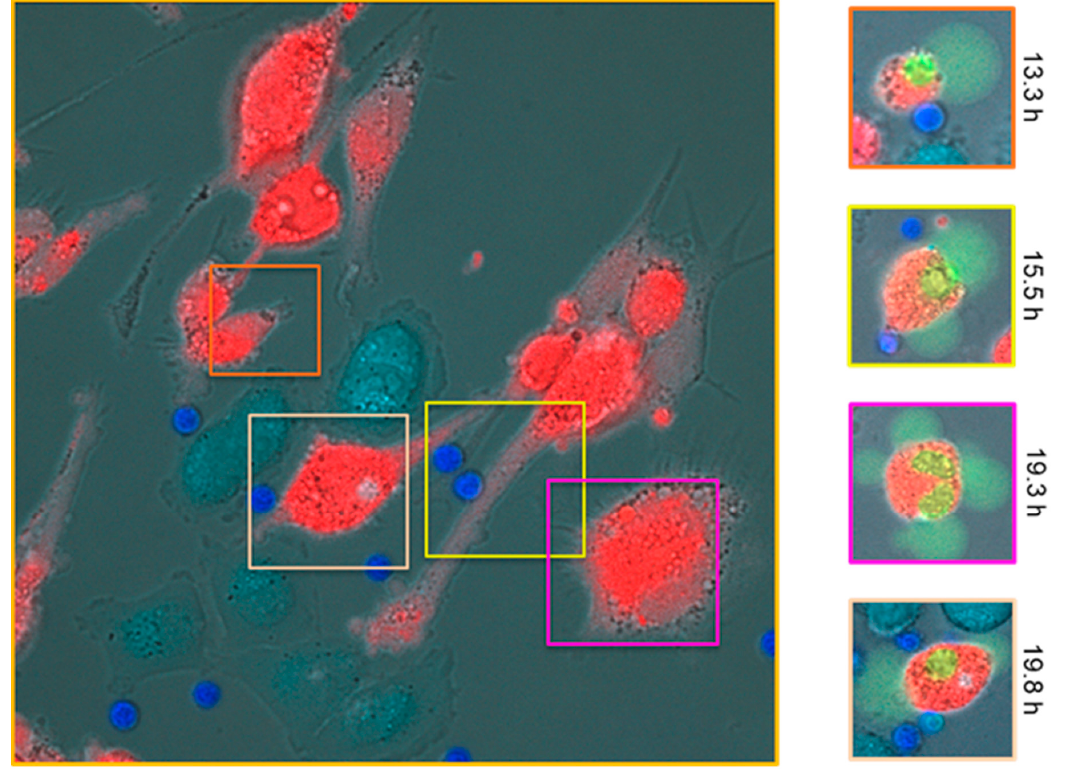
Figure 3. Images from time-lapse video microscopy taken in dose-response experiments in vitro conducted over a range of successive time points from 0–20 h showing tebentafusp (80 pM)-mediated killing of gp100-positive HLA-A*02:01-positive uveal melanoma (UM) cells (92-1; red) by CD8 + T cells (dark blue). Melanoma cells that are gp100-negative, HLA-A*02:01-positive—an HLA-matched control—(A375; pale blue) are ignored by CD8 + T cells. The main image (left) represents t = 0 in the assay and is captured with a 63 × oil immersion objective on Zeiss Axiovert 200M inverted microscope. The areas of green shown in the time-lapse images on the right-hand side are a dye activated by active caspase 3 / 7 to bind DNA and fluoresce, highlighting cellular apoptosis as a direct result of on-target tebentafusp-mediated T-cell redirection. The times where apoptosis of the highlighted target cells are first observed are denoted on the right and the border colours correspond to the same colour square in the main (left) image. Note the change in morphology of the cells on the right in line with the observed apoptosis as indicated by the green dye; UM, uveal melanoma.